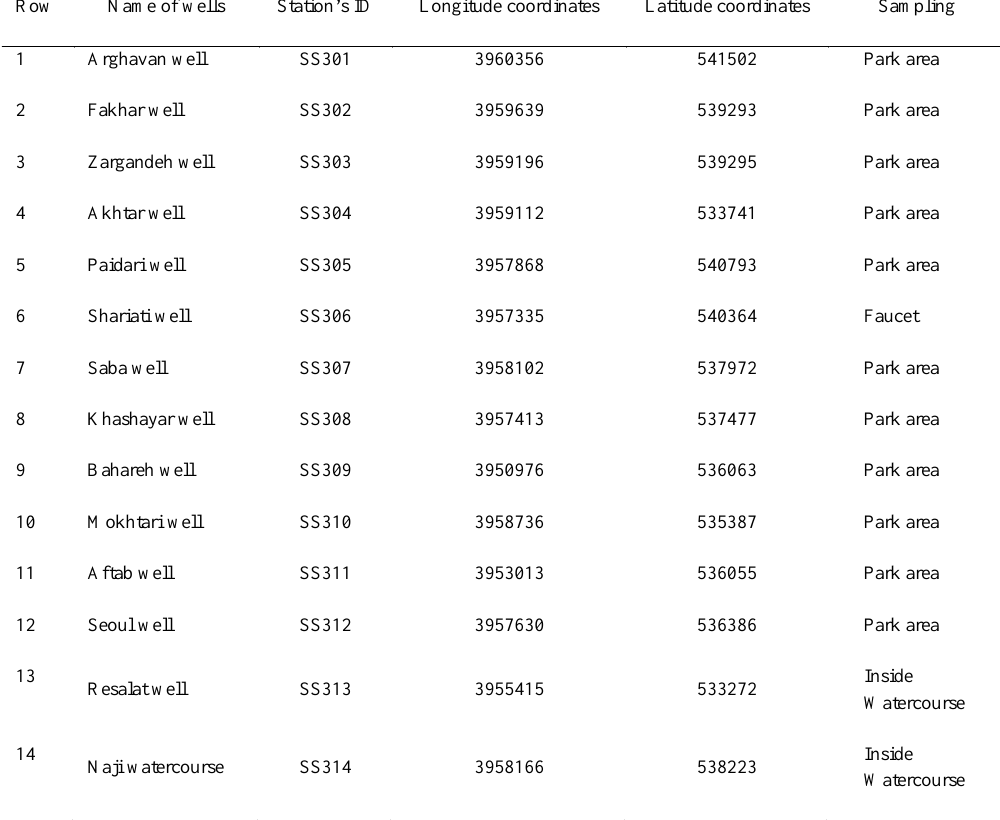
Table 1: Geographical location of the wells in the studied